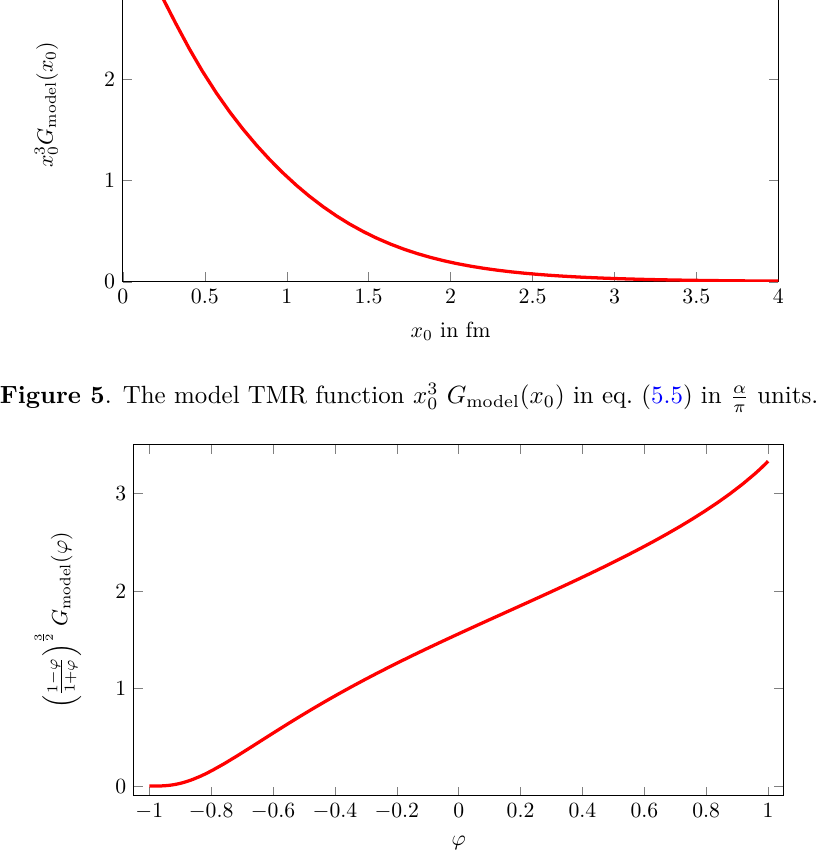
Figure 6 . The model TMR function x 3